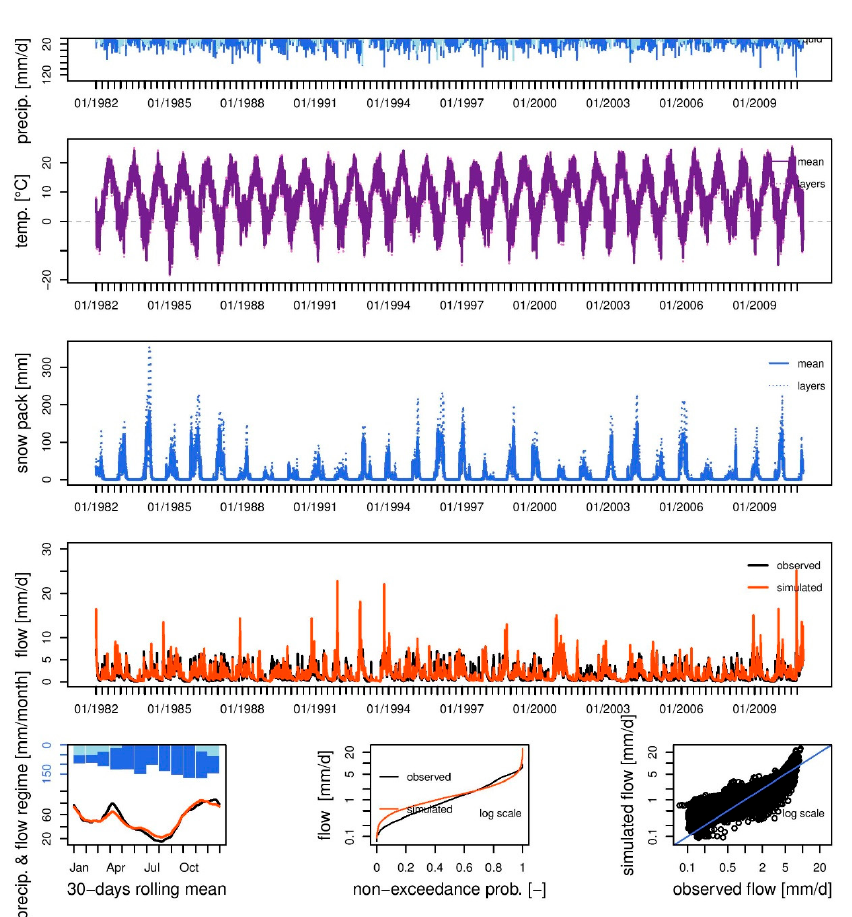
Figure 3. Hydrological modelling results using the CemaNeige GR6J model for the Vrhnika station on the Ljubljanica River for the calibration period (1982–2010; 1981 is used for model warm-up).